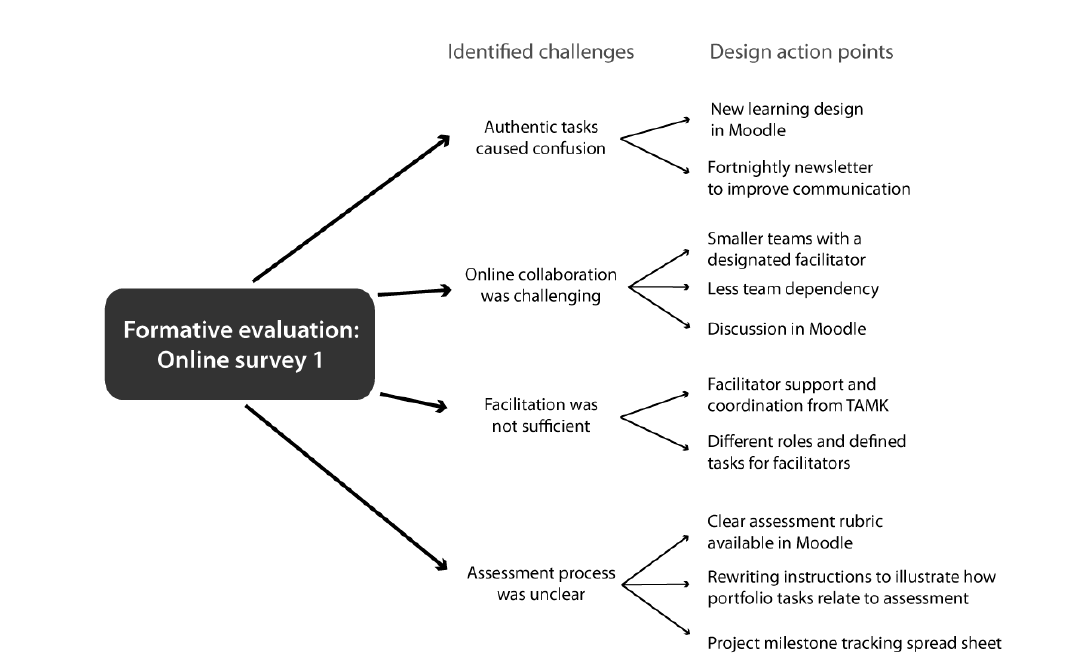
Figure 2 . Translation of evaluation results into design action